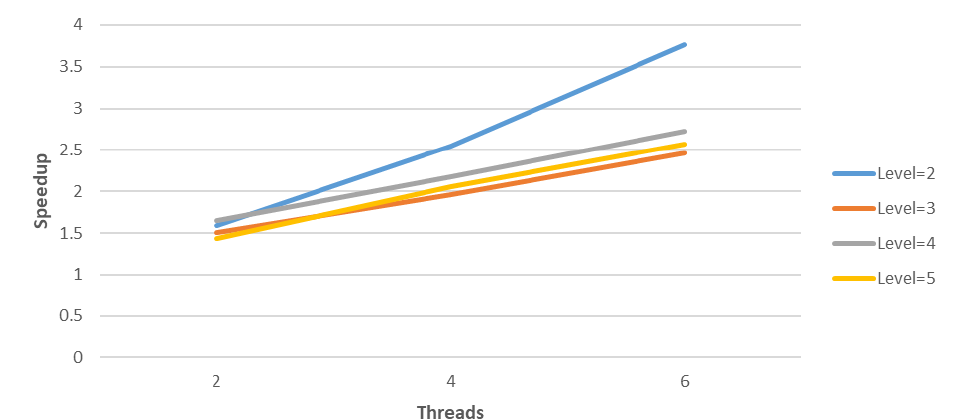
Figure 5. Speedups of parallel V cycle of AGAMG in combination with deflation technique and MGenFAspI with droptol = 0 and l fill = 2 for 3D Poisson model problem with nx =